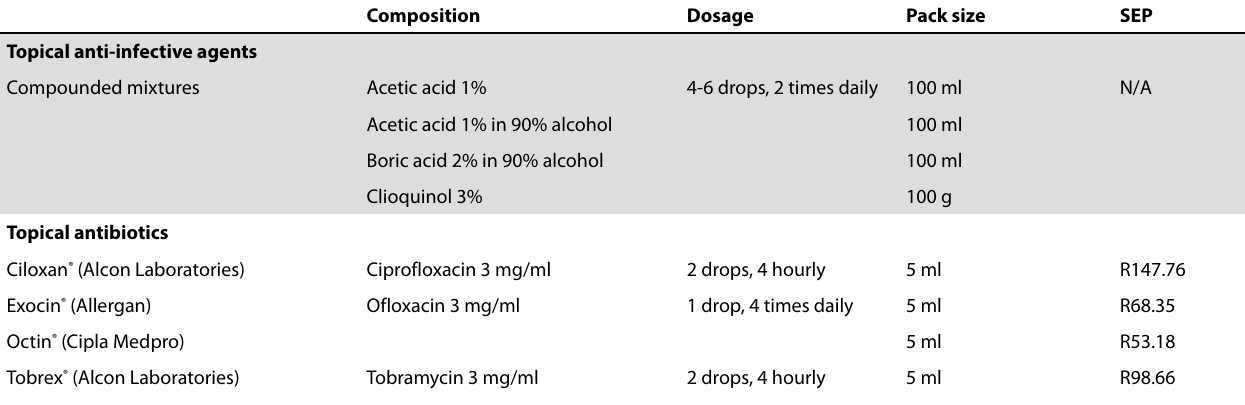
Table I: Currently available topical preparations in South Africa for the treatment of otitis externa